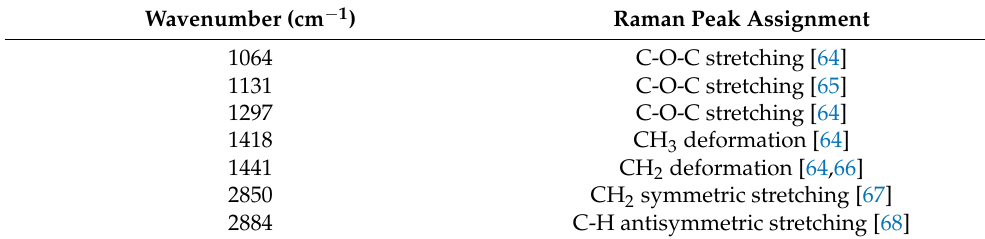
Table 2. Major Raman peaks identified and their related assignments.